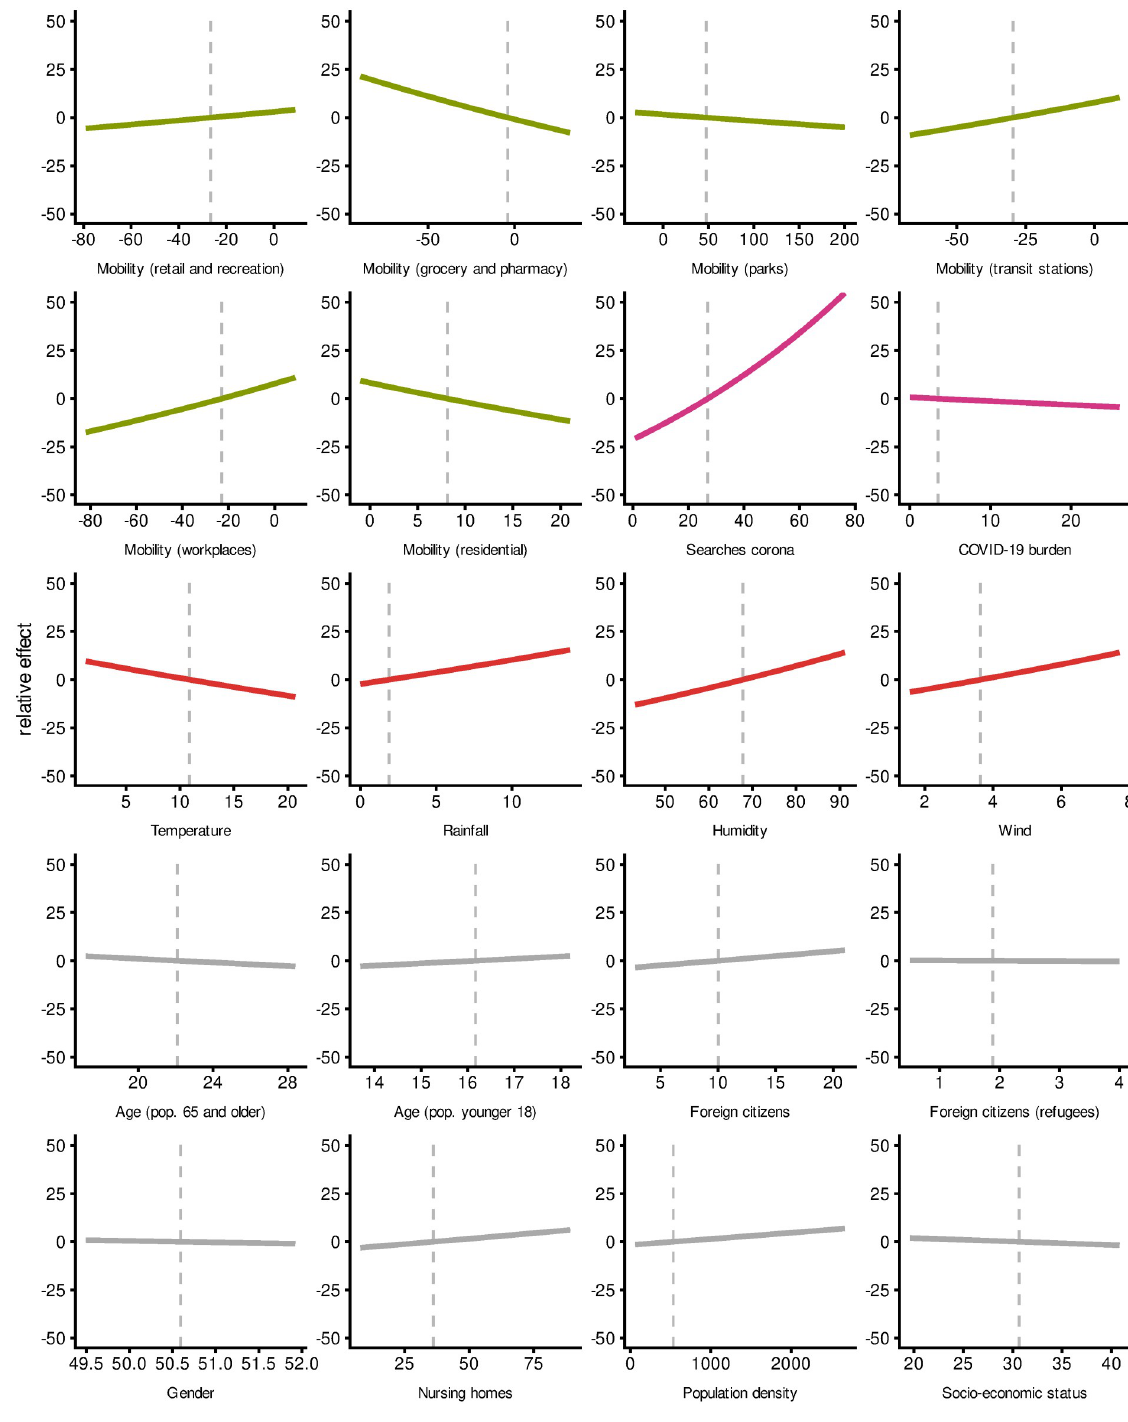
Fig 4. Relative causal effects of